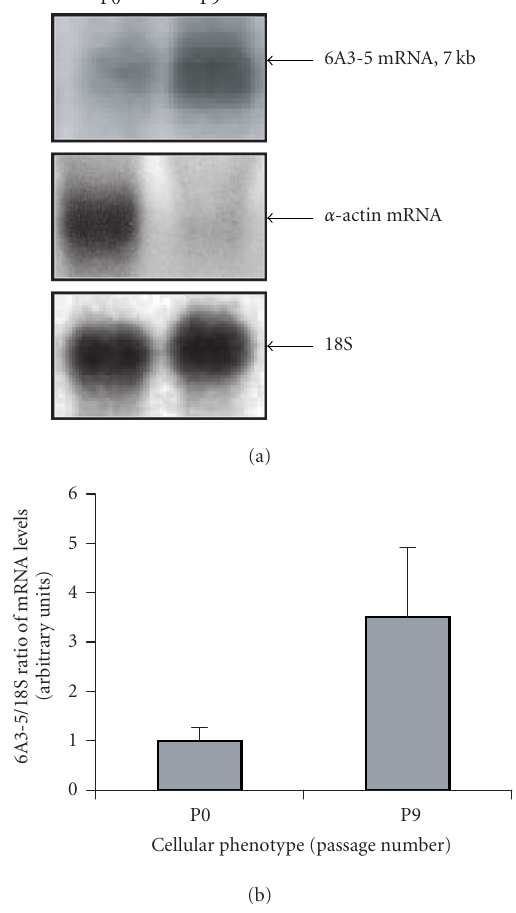
Figure 8. Functional characterization of 6A3-5 in vitro . (a) Levels of 6A3-5 gene transcription were compared, by north- ern blot, between the contractile (passage 0, P0) and the se- cretory/synthetic phenotype (9th passage, P9). Northern blots showed that 6A3-5 mRNA transcription levels are very low in the contractile phenotype, in comparison to the synthetic one. The contractile phenotype (P0) and its loss (P9) were character- ized by the α -actin marker as a positive internal control of the experiment. The 18S served as a control for loading and quan- tification. (b) Quantification of 6A3-5 signals, done on 3 inde- pendent northern blots, reported to the 18S levels. Results show that 6A3-5 mRNA levels are increased by 300% (3-fold increase) in synthetic cells compared to contractile cells. Results are rep- resented in a quantitative way with the mean + / −